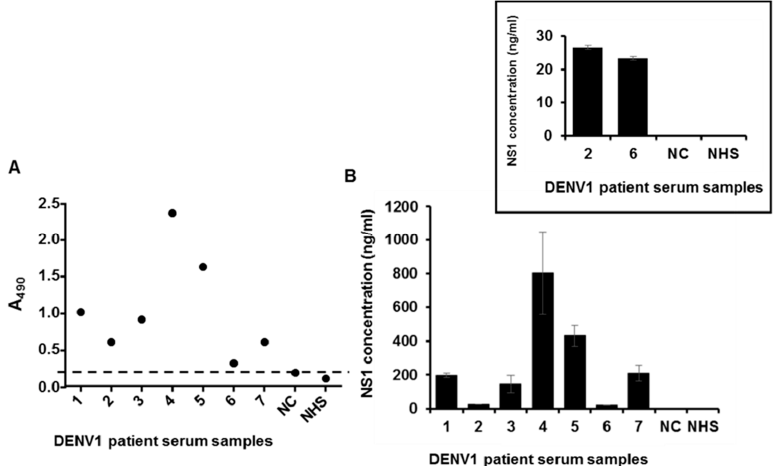
Figure 4. Cont. Figure 4. Cont